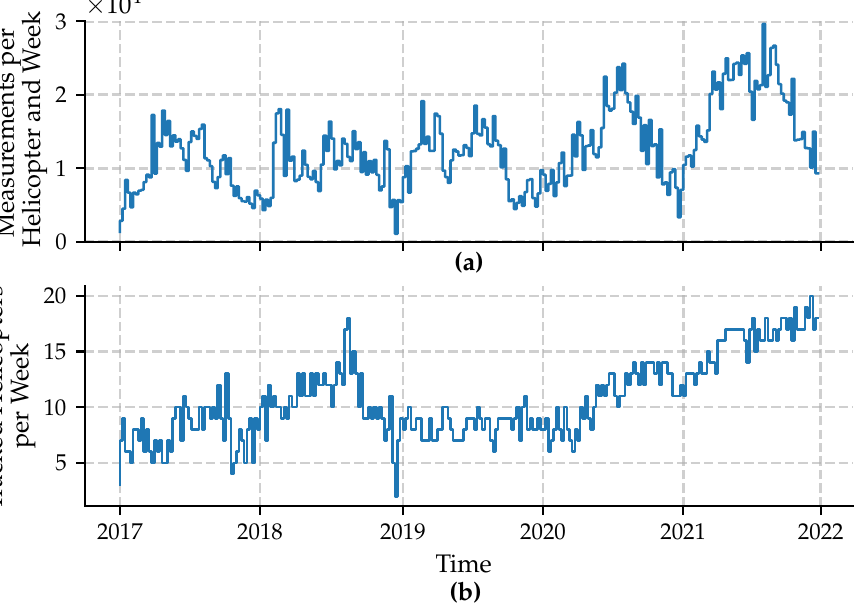
Figure 6. ( a ) Mean number of measurements per helicopter within the filtered data set. ( b ) Number of tracked helicopter registrations per week.